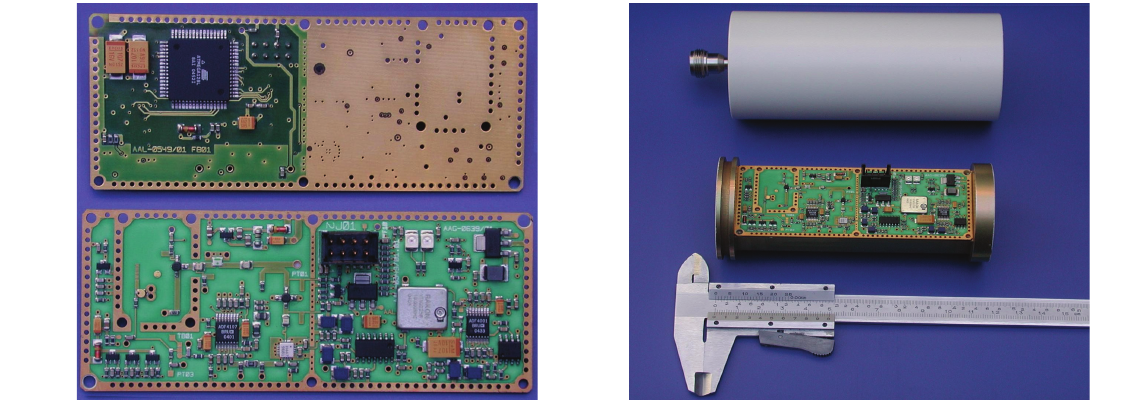
Figure 5: The prototype.